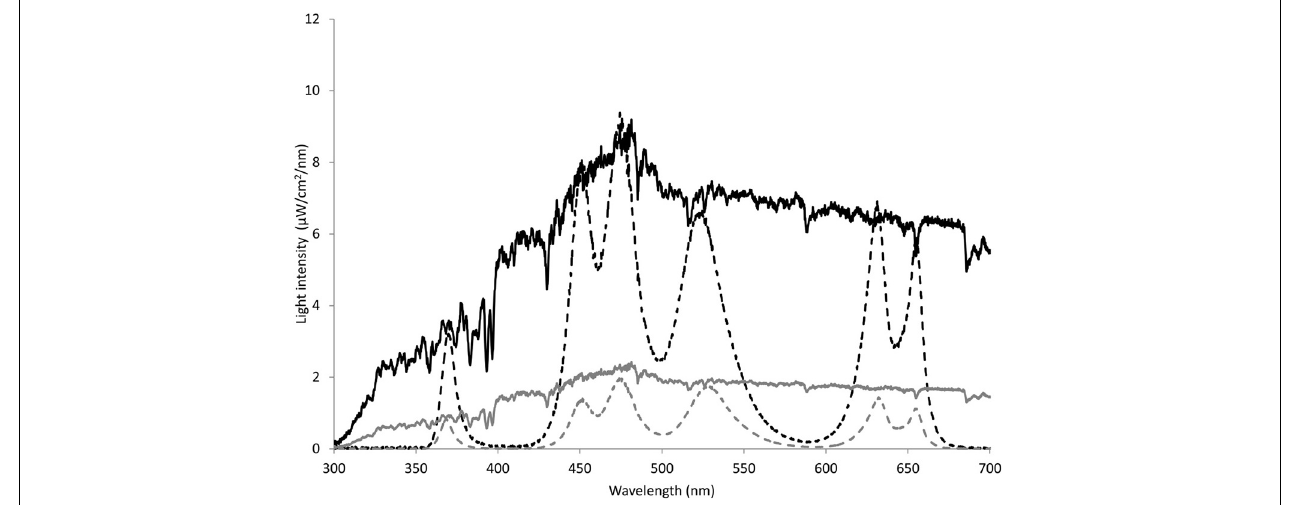
FIGURE 1 | Measured solar radiation (10%) and simulated light regime under spring and autumn light conditions. Light intenstity ( μ W/cm 2 /nm) of the LEDs for SPRING (black dotted line) and AUTUMN (gray dotted line) were normalized to 10% of the average solar radiation (black and gray line,